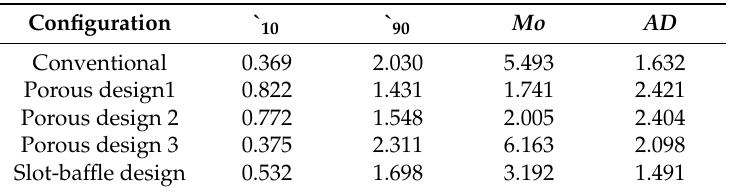
Table 3. Characteristic time indexes for contact tank